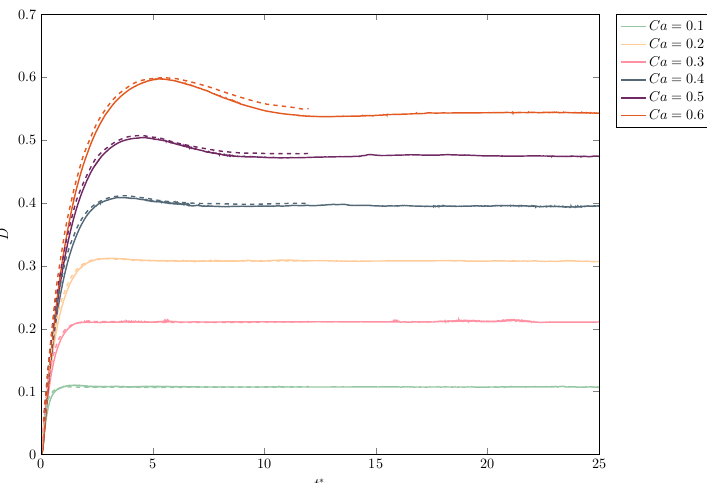
Figure 3. Comparison of the evolution of deformation for a Newtonian drop in a Newtonian matrix of equal viscosity, for different values of capillarity Ca , between our results (solid line) and those found in Afkhami et al. [74] (dashed line).